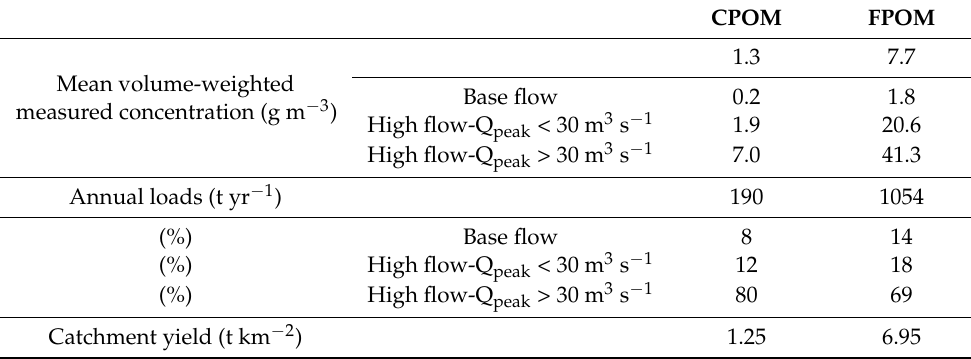
Table 2. CPOM and FPOM mean volume-weighted measured concentrations (g m − 3 ) and annual loads (t yr − 1 ) and variation in relation to discharge; catchment yield (t km − 2 ). CPOM